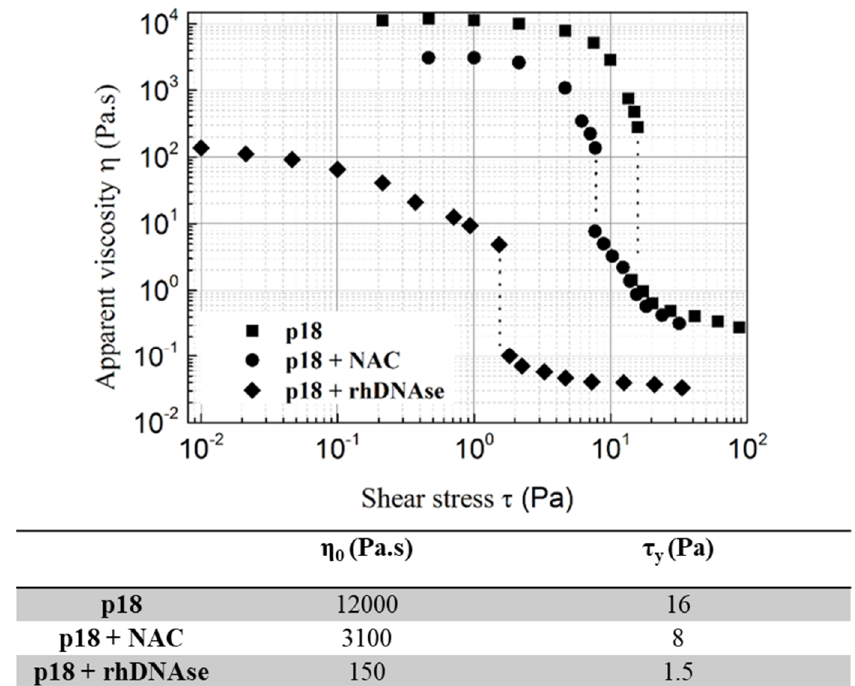
Figure 2. ( A ) Graphical comparison of rheological data obtained in oscillatory and steady shear flow of mucus from spontaneous or induced CF expectoration collected for this study. Storage modulus (G (cid:48) ) and loss modulus (G (cid:48)(cid:48) ) data were measured at a strain amplitude of 1% and at an angular frequency of 0.1 rad.s − 1 and tan δ = G (cid:48)(cid:48) /G (cid:48) . ( B ) Graphical comparison of apparent yield stress ( τ γ ) and Newtonian viscosity ( η ) of untreated and rhDNAse-treated mucus. Statistical analysis with the non-parametric Mann–Whitney test was performed to compare τ γ and η values in patients from the two groups; the symbol “*” denotes a p value < 5%.